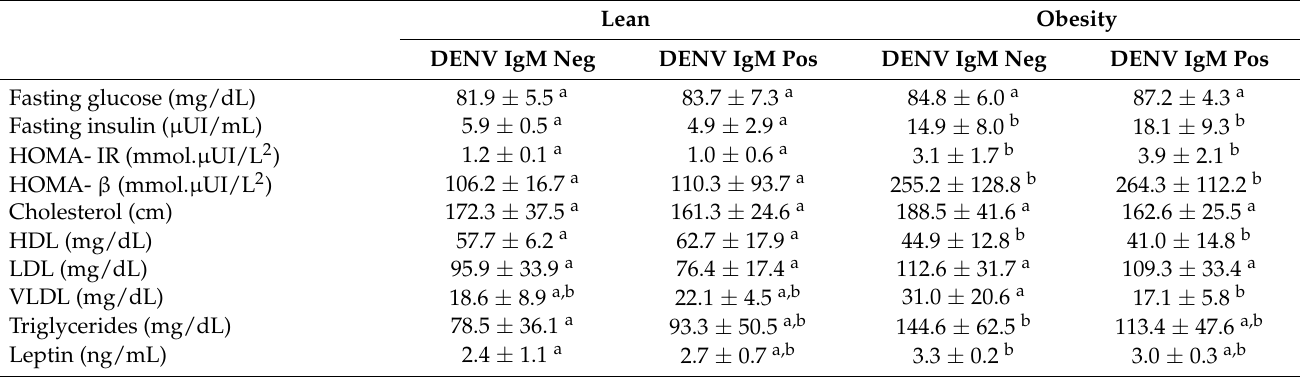
Table 2. Endocrine and metabolic data of the study’s participants.